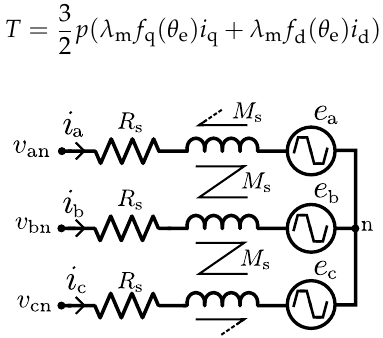
Figure A1. Schematic of the electrical components within the BLDC